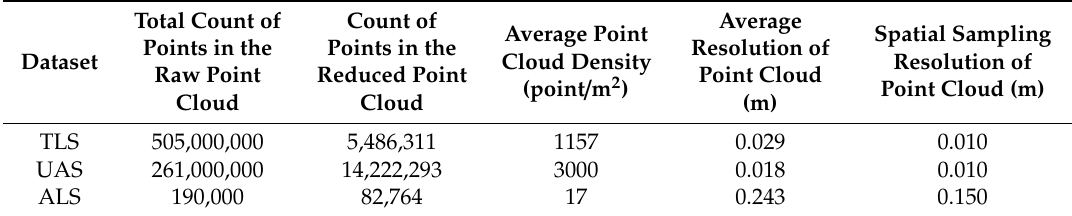
Table 4. Properties of the datasets.